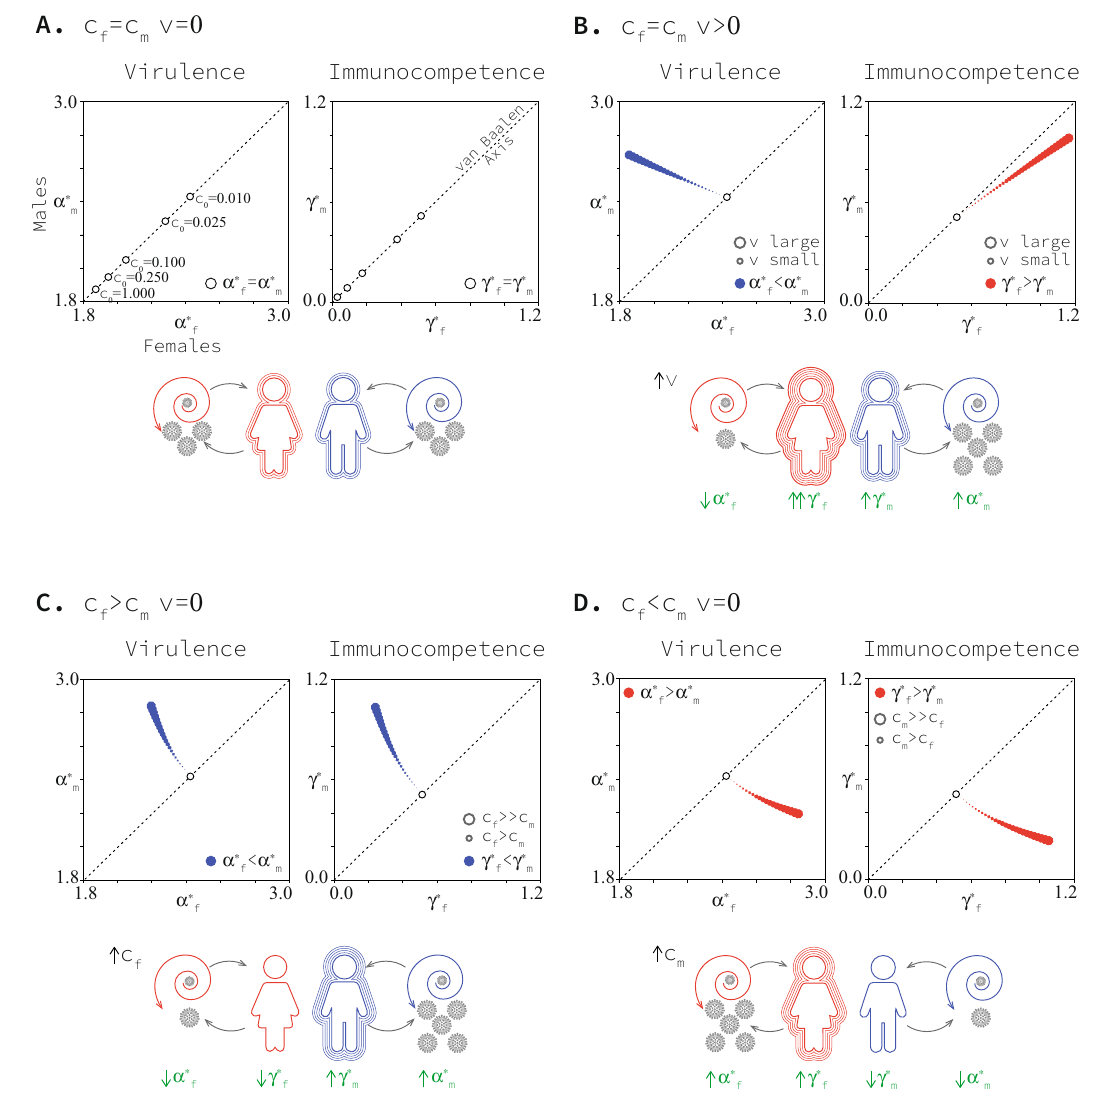
Fig. 3 | Co-evolved levels of virulence and immunocompetence in each sex. Panel A presents the case when there are no differences between the sexes. In the absence of differences between the sexes, trajectories converge to the main diag- onal (the van Baalen axis), recovering previous non-sex-speci fi c co-evolutionary results 27 . Panel B presents the case when the only difference between the sexes is